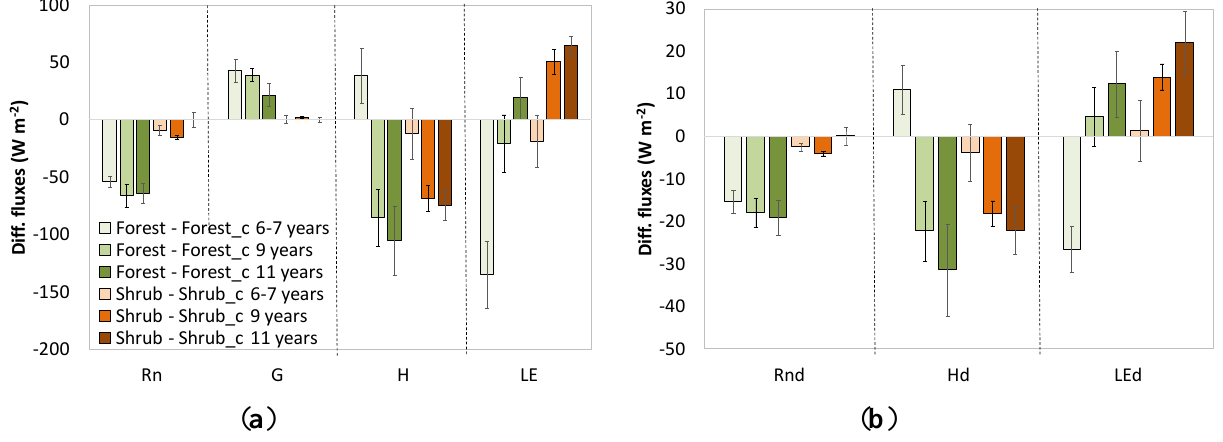
Figure 6. Average values of the differences between burnt and unburnt areas in terms of R n , G , H , and LE : ( a ) instantaneous fluxes; ( b ) daily fluxes. Error bars represent the standard deviations of the